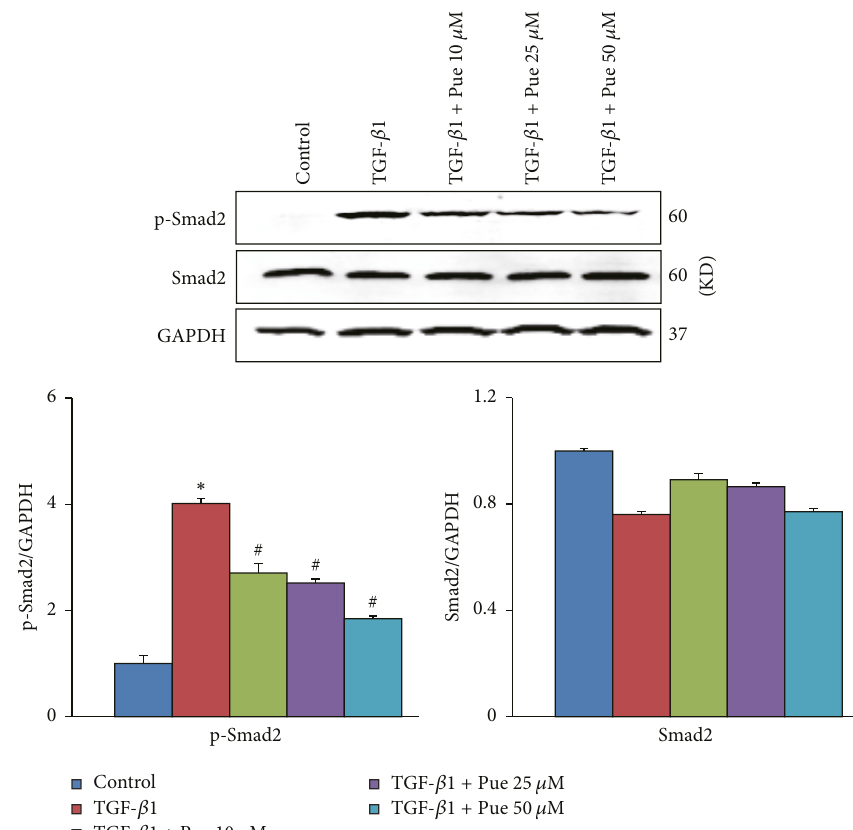
Figure 5: Puerarin inhibited Smad2 phosphorylation in HUVECs. HUVECs were preincubated with different concentrations of puerarin (10, 25, and 50 𝜇 M) for 30min and then treated with TGF- 𝛽 1 (10ng/ml) for 48 h. Protein levels of p-Smad2 and Smad2 in cell lysates in indicated groups were detected by WB, normalized to GAPDH (𝑛 = 6) . ∗ 𝑝 < 0.05 versus control group; # 𝑝 < 0.05 versus TGF- 𝛽 1 group.